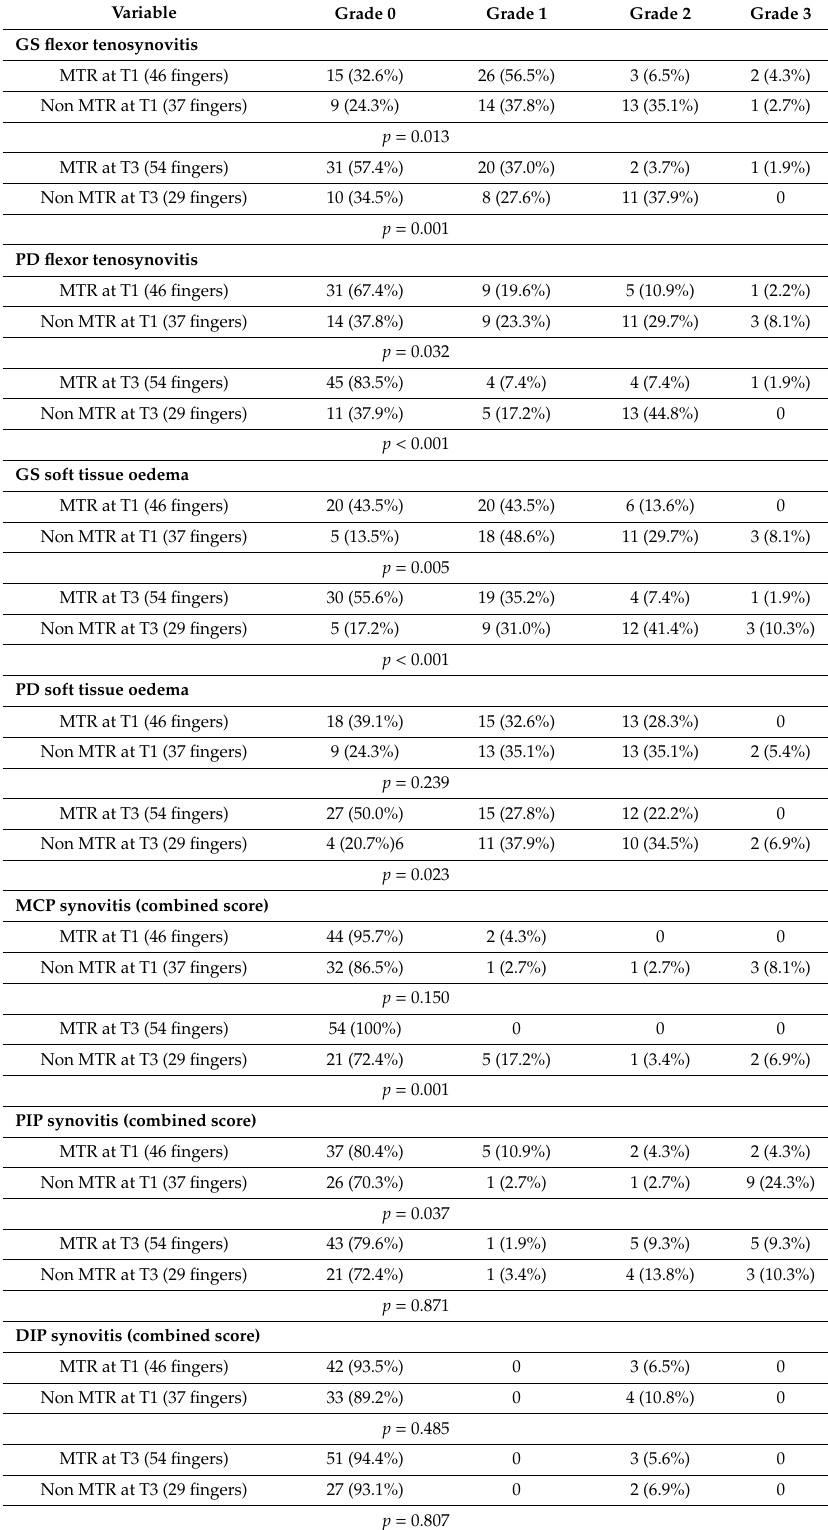
Table 3. Prevalence of ultrasound abnormalities at 1 month and 3 months according to the patients’ meaningful treatment response (MTR). Peritendon extensor inflammation is not reported due to low case prevalence ( p not